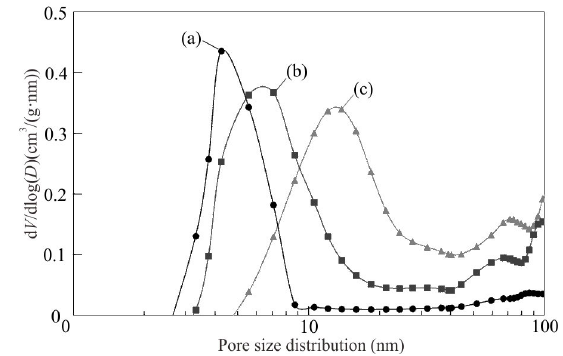
Fig. 5 Pore size distribution of the hollow silica–alumina composite spheres prepared using (a) 40, (b) 80, and (c) 120 g of the PS suspension, calculated using the BJH method.